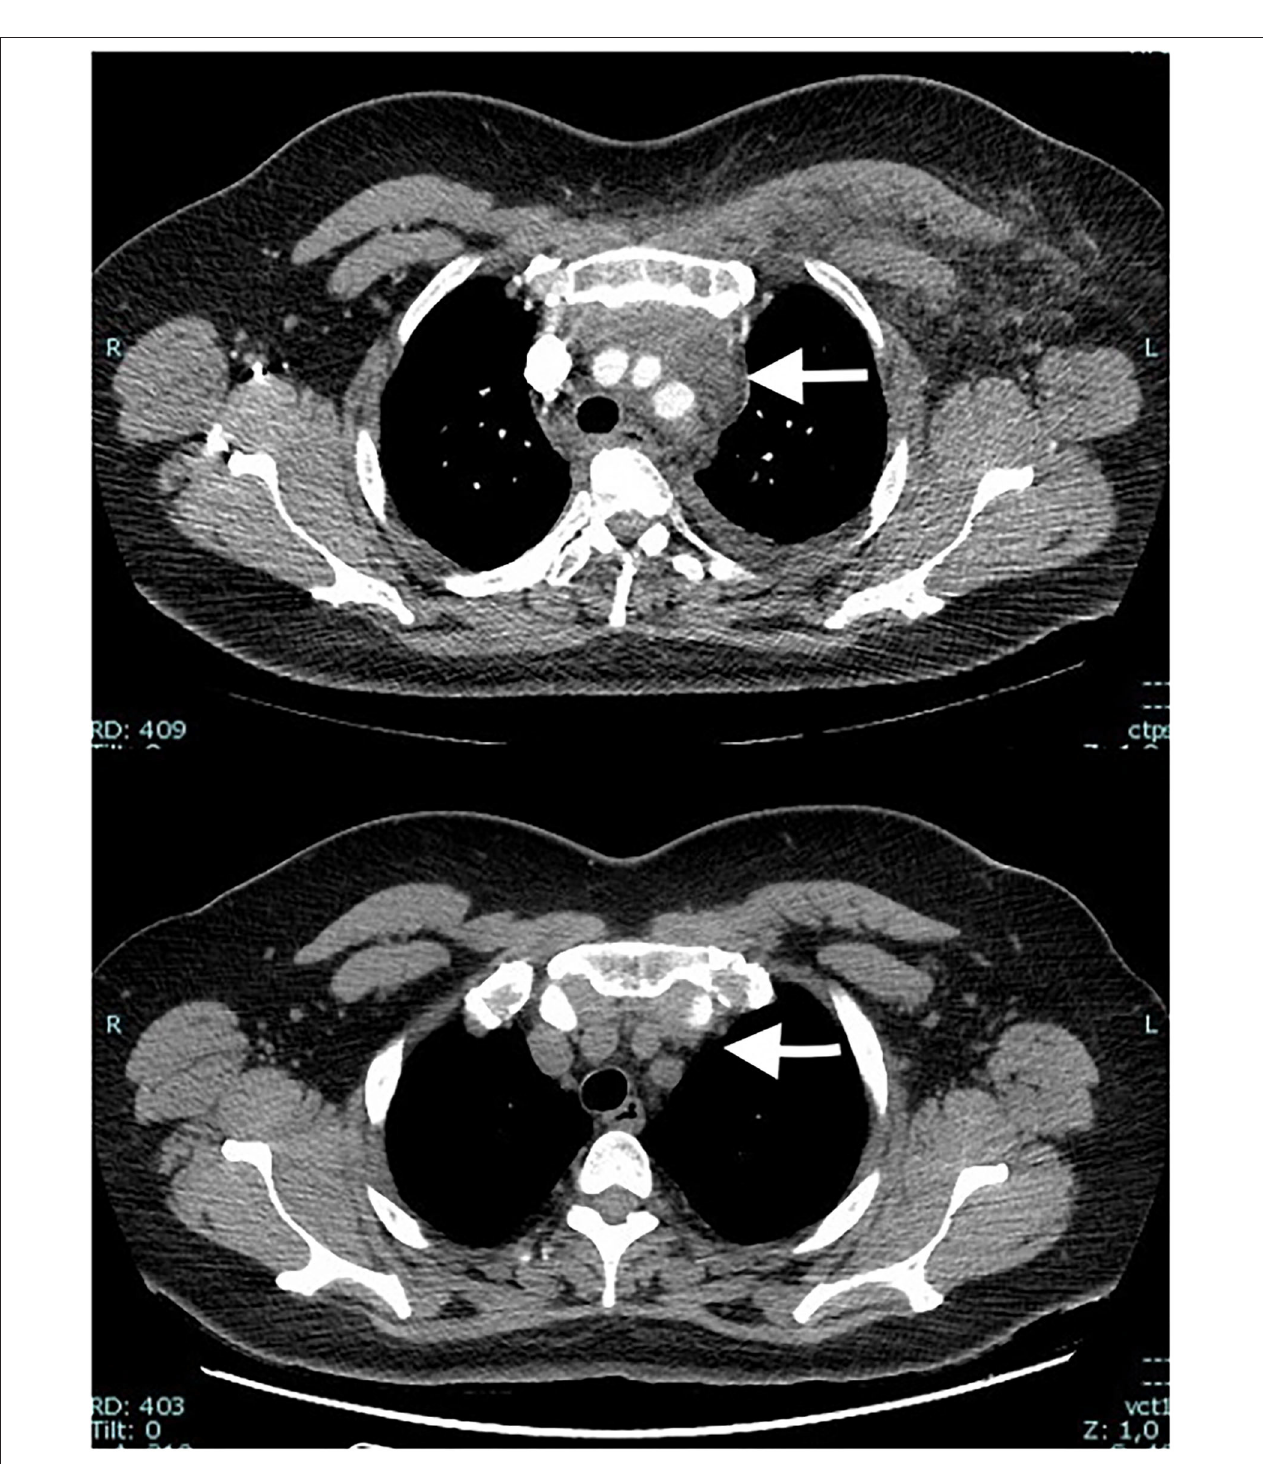
FIGURE 1 | Contrast medium Chest Computed Tomography showing a mass of the upper anterior mediastinum compressing and displacing the left anonymous vein that is occluded (above) (white arrow). After 6 weeks, after the resolution of the SARS-CoV-2 the mass disappeared (white arrow). to the pulmonary embolism, prompted us to delay the with negative culture and histological results. A surgical procedure. The patient was relocated in a dedicated SARS-CoV- mediastinal mass biopsy by VATS was therefore planned, but 2 department where she was treated with azithromycin and a new SARS-CoV-2 nasal swab was positive. This, together